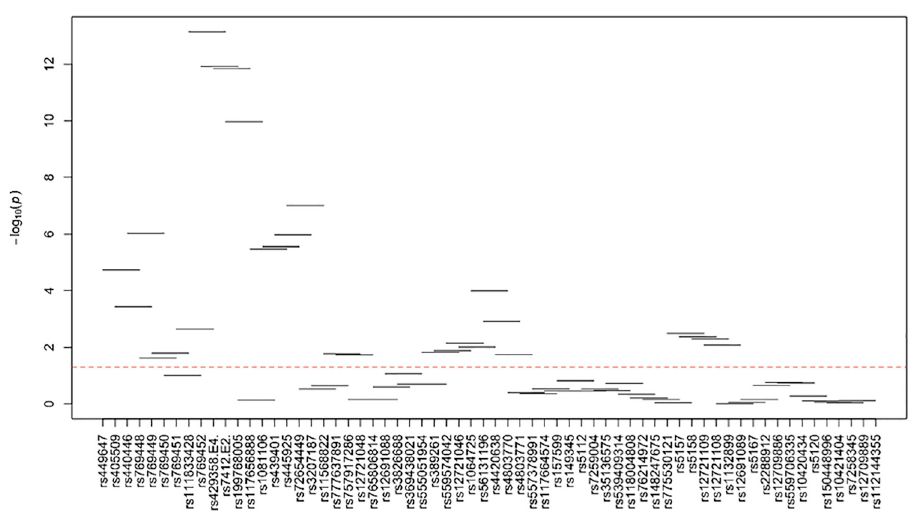
Fig 7. Plots of haplotype-based association analysis results for ApoB in NHWs. Horizontal lines represent the 4-SNP windows. X-axis direction shows the SNPs genotyped in the regions based on the order of APOE , APOC1 , HCR1 , HCR2 , APOC4 and APOC2 while the Y-axis shows the–log (global p-value) with red line representing the p- value threshold (P = 0.05).